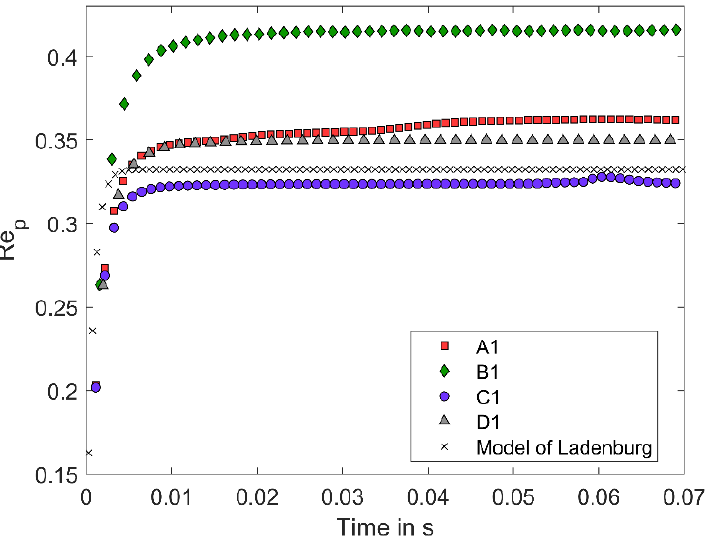
Figure 13. Particle Reynolds number 𝑅𝑒 𝑃 from simulations A1, B1, C1 and D1 compared to the theoretical sedimentation curve according to Ladenburg.